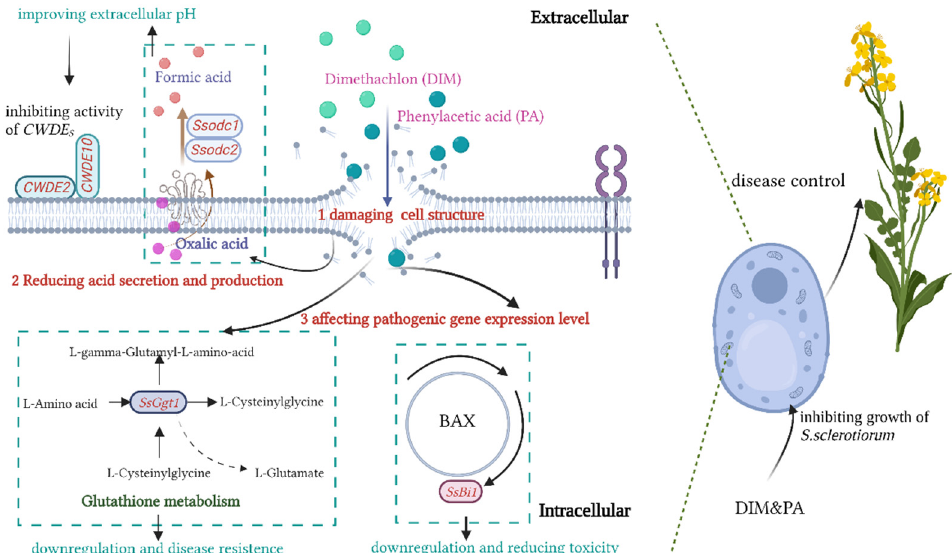
Figure 8. Possible mechanisms regarding the role of DIM and PA in reducing the pathogenicity of S. sclerotiorum . (1) PA and DIM damaged the cell structure; (2) PA and DIM changed pathogenic factors and growth environment; (3) PA and DIM regulated the expression level of the pathogenicity gene.